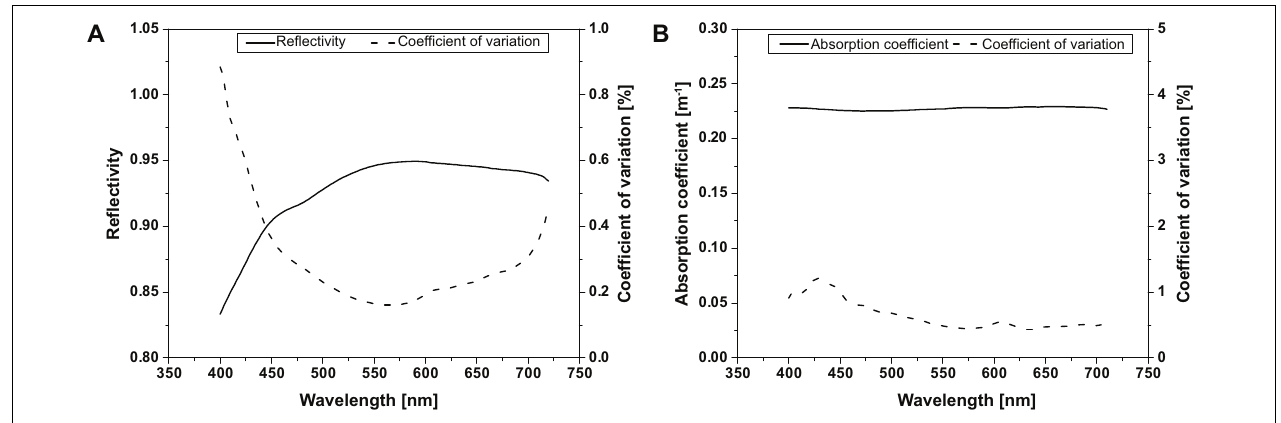
FIGURE 8 | Characterization of the solid standard in the HyAbS. (A) Reflectivity determined in the initial calibration. (B) Spectral absorption coefficients of the solid standard.